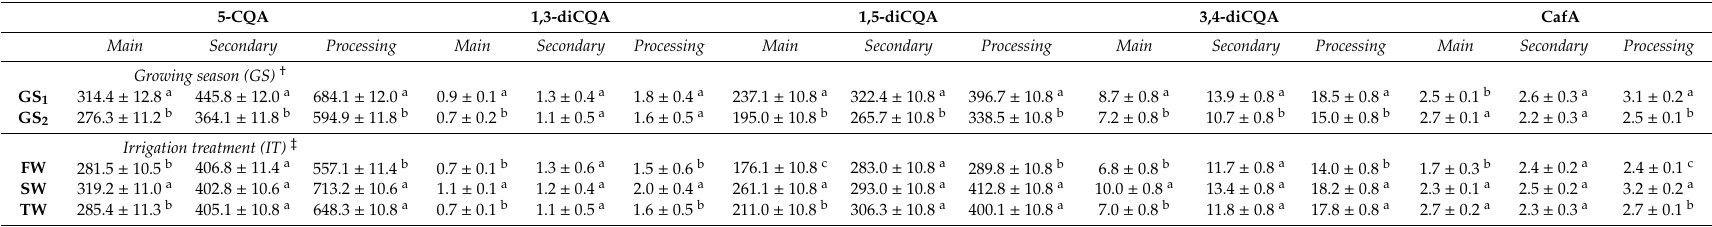
Table 3. E ff ects of the main experimental factors (growing season and irrigation treatment) on main ca ff eoylquinic acid derivatives (mg 100 g − 1 d.w.) of main, secondary, and processing artichoke heads. 5-CQA 1,3-diCQA 1,5-diCQA 3,4-diCQA